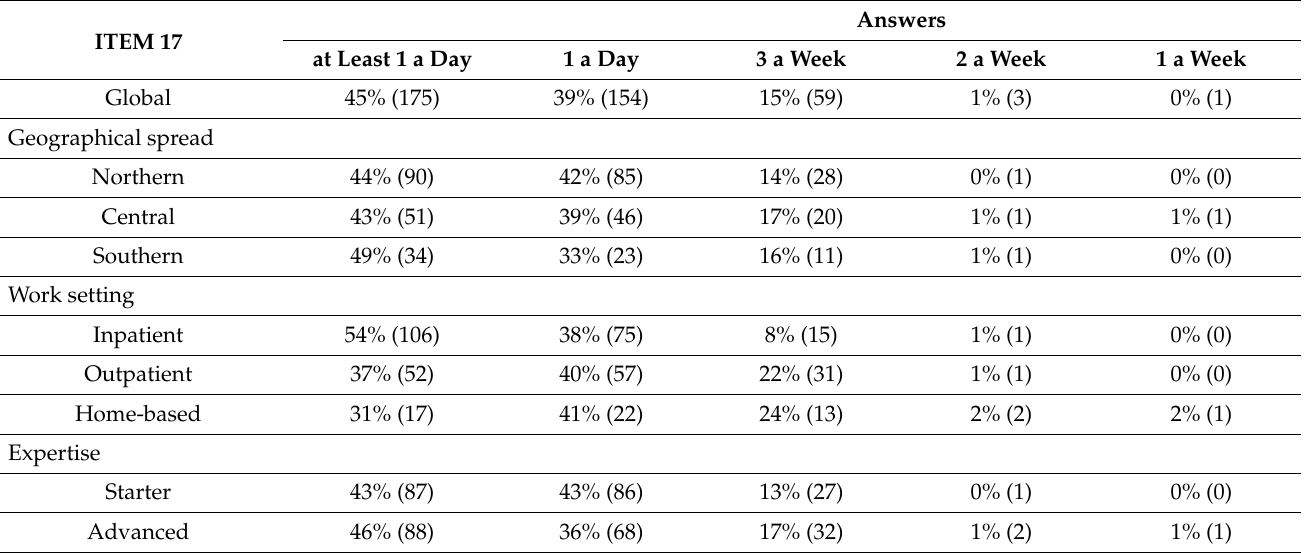
Table 4. Answers referred to item 17: In your opinion, what is the optimal number of physiotherapy sessions in the acute phase for a patient with hip fracture?